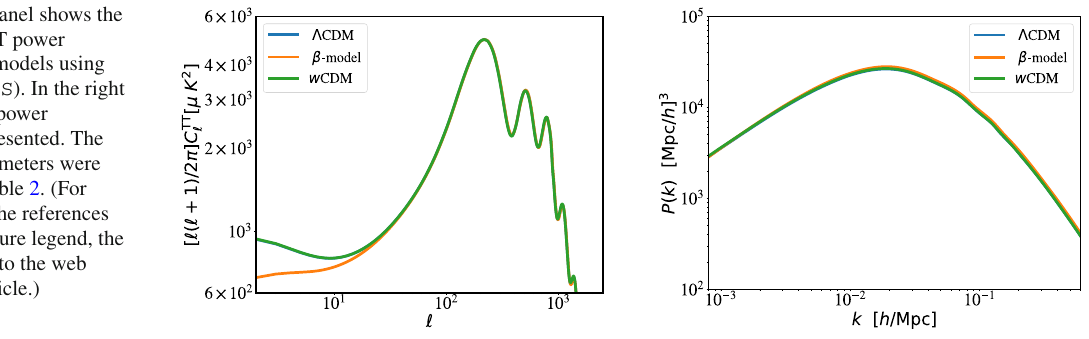
Fig. 4 The left panel shows the unlensed CMB TT power spectrum for the models using CLASS ( EFCLASS ). In the right panel, the matter power spectrum P k is presented. The values of the parameters were extracted from Table 2. (For interpretation of the references to color in this figure legend, the reader is referred to the web version of this